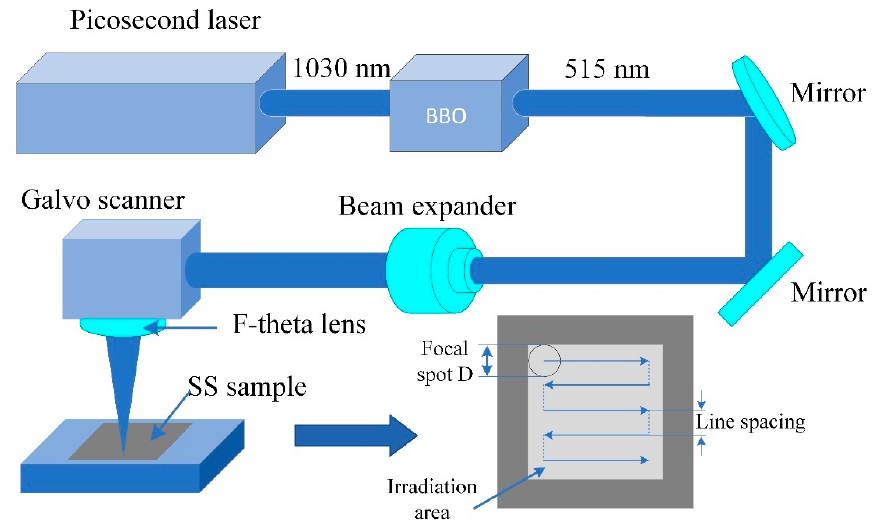
Figure 1. Schematic setup of the picosecond (ps) laser scanning system for fabrication of hierarchical periodic near-subwavelength ripples (NSRs) and deep-subwavelength ripples (DSRs).